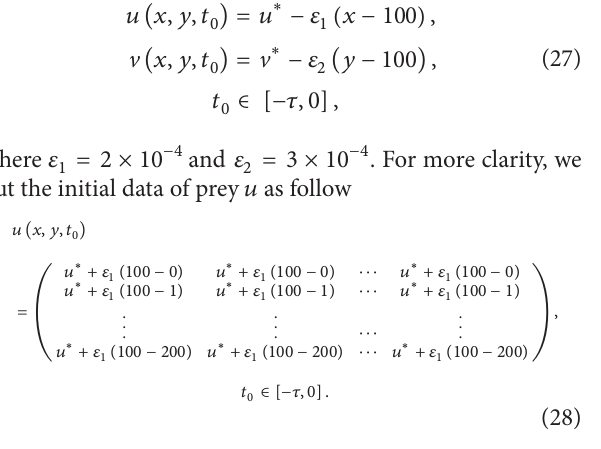
Figure 2: Stationary Turing patterns of 𝑢 in model (4) at time 𝑡 = 2000 with parameters 𝑎 = 0.43 , 𝑏 = 0.22 , 𝑐 = 0.4 , 𝑟 = 1.4 , 𝑚 = 0.17 , 𝑑 11 = = 0.05 , 𝑑 = 0.37 , 𝜏 = 0.46 , and (a) (d) (𝑑,𝑑 0.4 , 𝑑 12 22 (0.61, 0.39, 0.75) , and the other parameters are fixed as (25). Times: 𝑡 = 2000